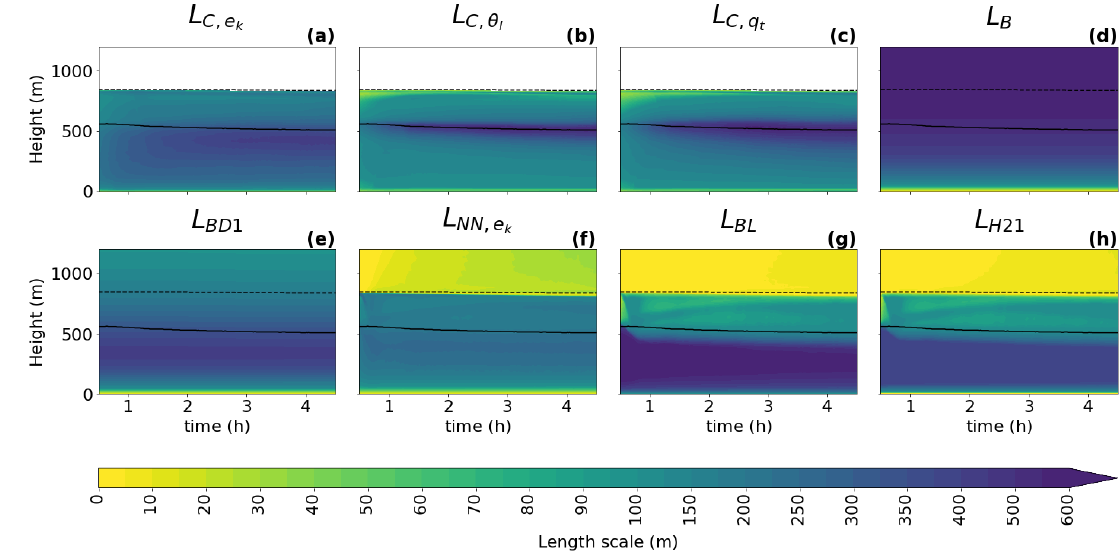
Figure 6. Same content as Figure 3, but for the DYCOMS-II case.